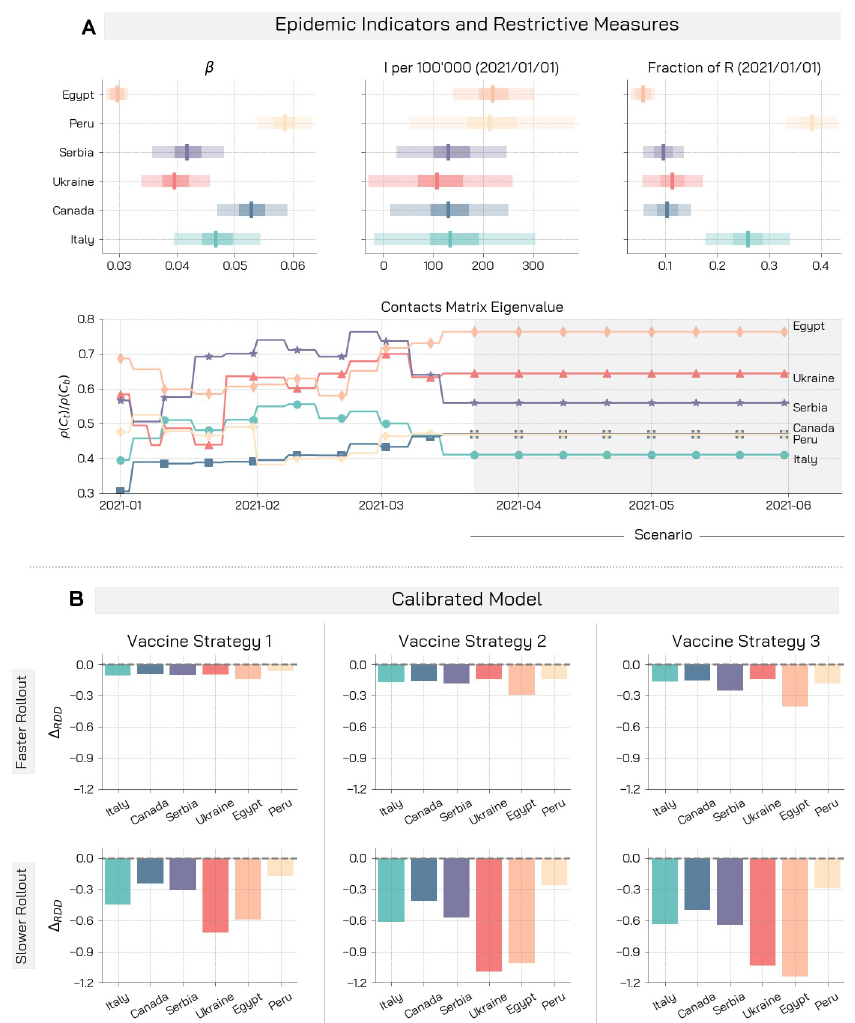
Fig 3. Giving up NPIs during rollout may nullify the benefits brought by the vaccine. A) We display for the different countries the boxplot of the calibrated infection parameter β , the projected number of symptomatic infectious cases per 100 0 000 and the fraction of recovered at the 2021/01/01, start of the vaccination campaign in our simulation. We also report the ratio between the leading eigenvalue of the contacts matrix considering restrictions and of the baseline contacts matrix with no restrictions. B) We display the median relative deaths difference for the calibrated model in the different countries. We consider the three vaccination strategies and two possible rollout speed: r (faster rollout), and r V = 0.25% (slower rollout). We run the model over the period 2021/01/01–2021/06/01. Other parameters are γ = 0.5, α = 10 2 , r = 1.3, VE S = 70% ( VE =